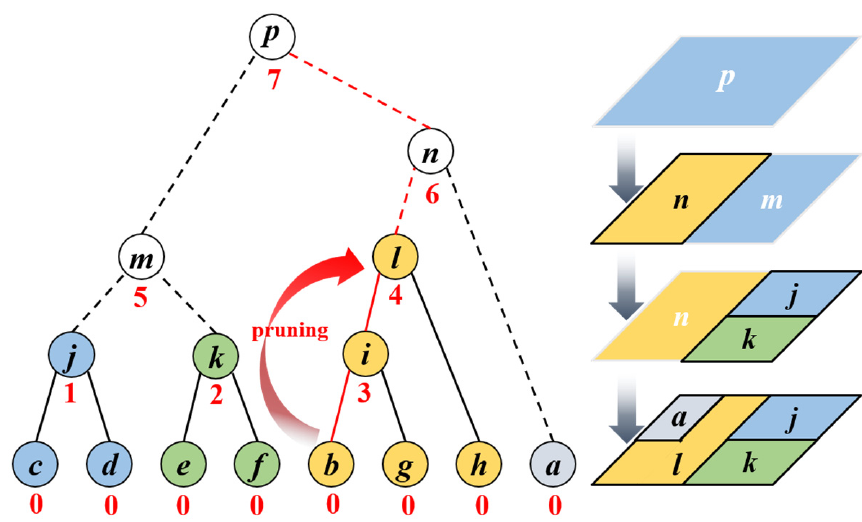
Figure 2. The branch pruning diagrams with pruning factor P = 4. ( left ) The hierarchical structure of branch pruning. ( right ) the 3-D branch pruning process. The letters represent the indexes of the objects, and the numbers represent the iteration numbers of each node.